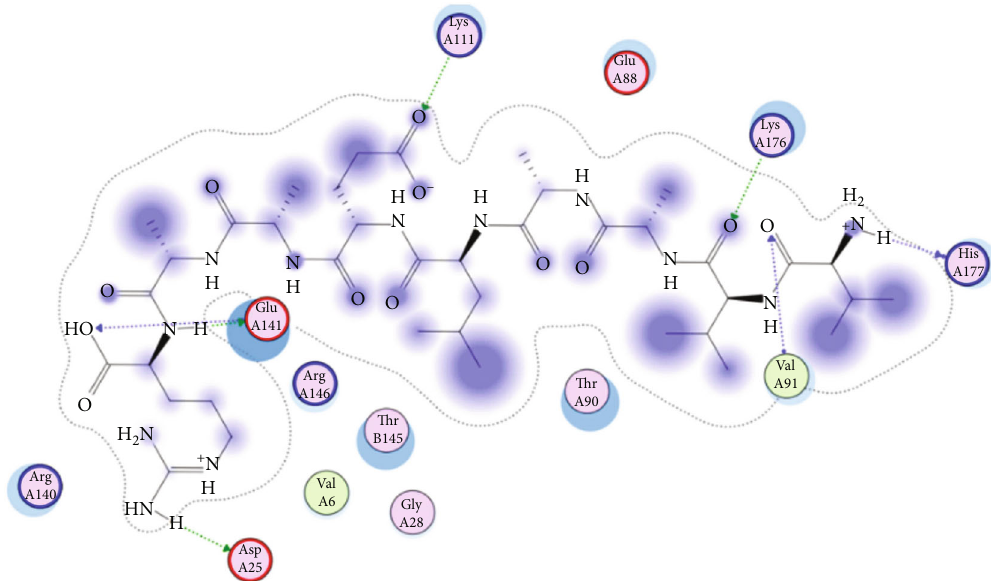
Figure 24: Illustration of the 2D interaction of the best docking poses of VVAALEAAR in the binding sites of HLA-DRB1 ∗ 01:01.